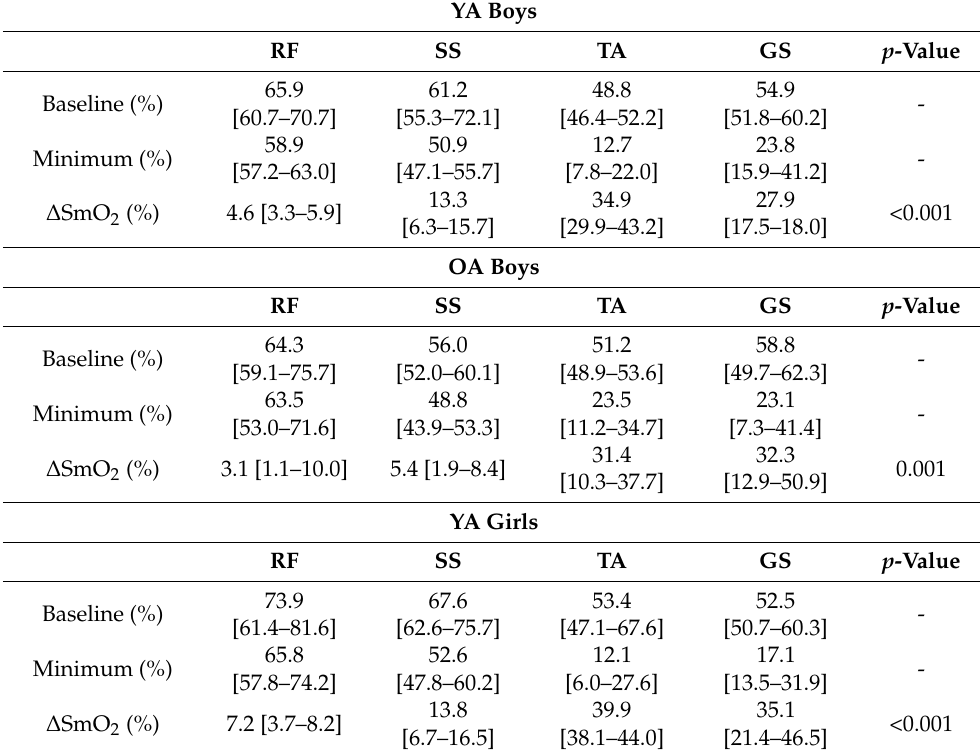
Table 2. The SmO 2 values for each muscle in the four